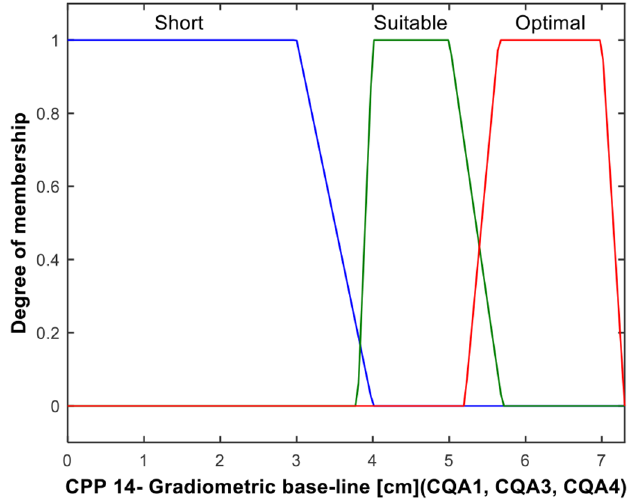
Fig. 7. Fuzzy sets of the CPP 14